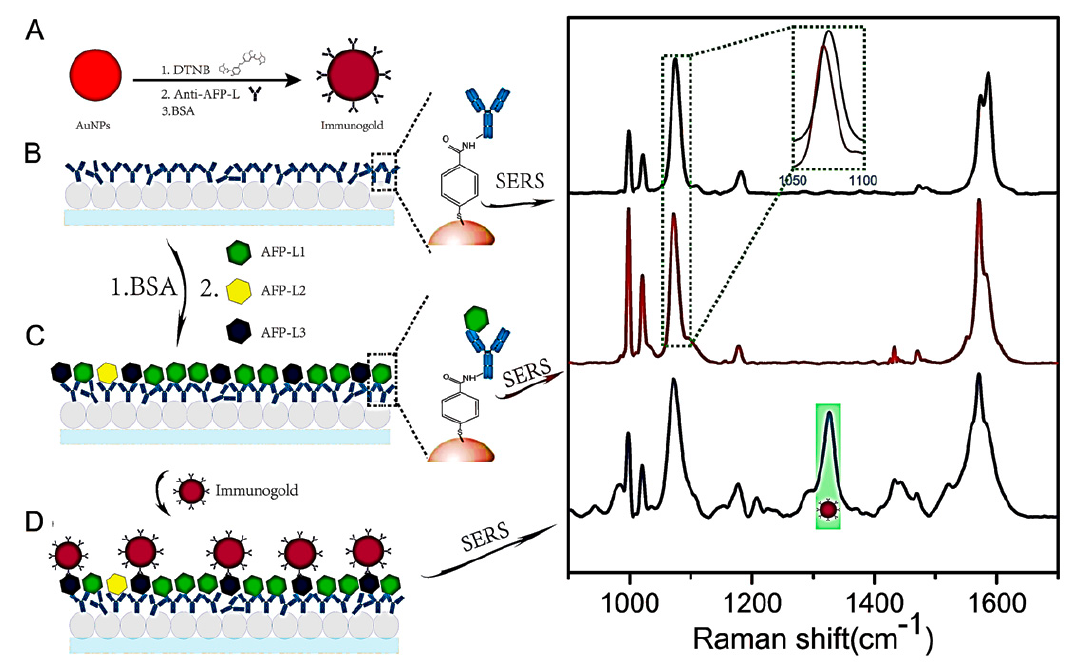
Figure 1. Schematic of a SERS-based immunoassay: ( A ) preparation of immunogold; ( B ) antibody capture chip fabrication; ( C , D ) reproduced with permission from [13]. (Copyright 2017, ACS.)